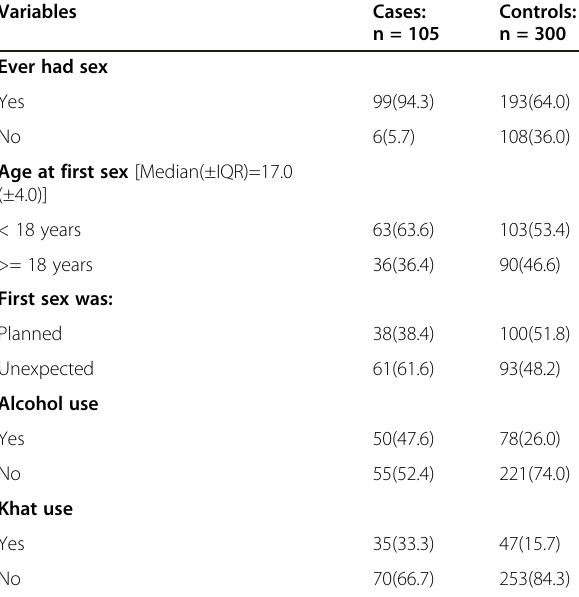
Table 2 Sexual and non-sexual behaviors of youths visiting HIV testing and counseling centers in Gamo- Gofa, South West, Ethiopia, 2012